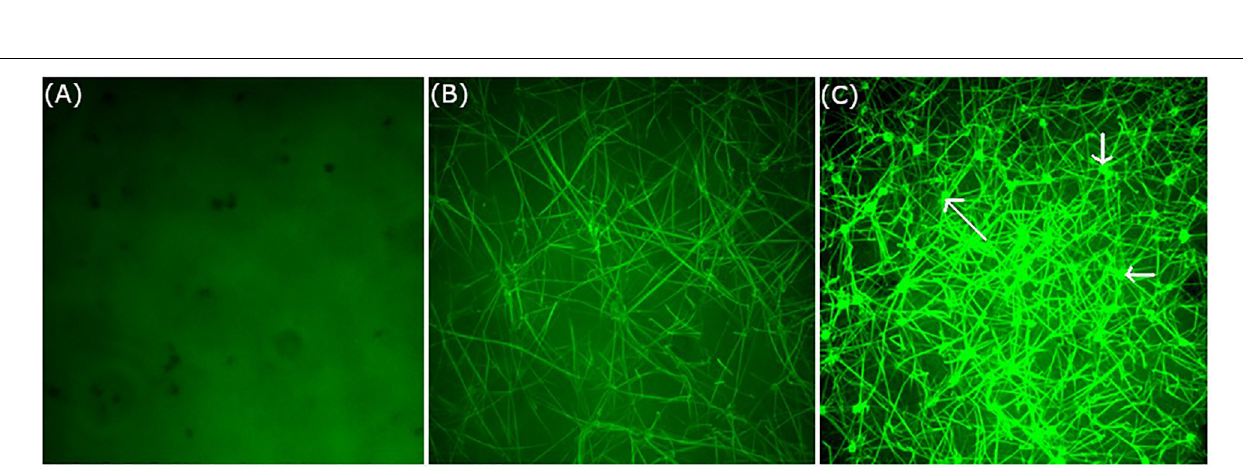
Frontiers in Physiology |